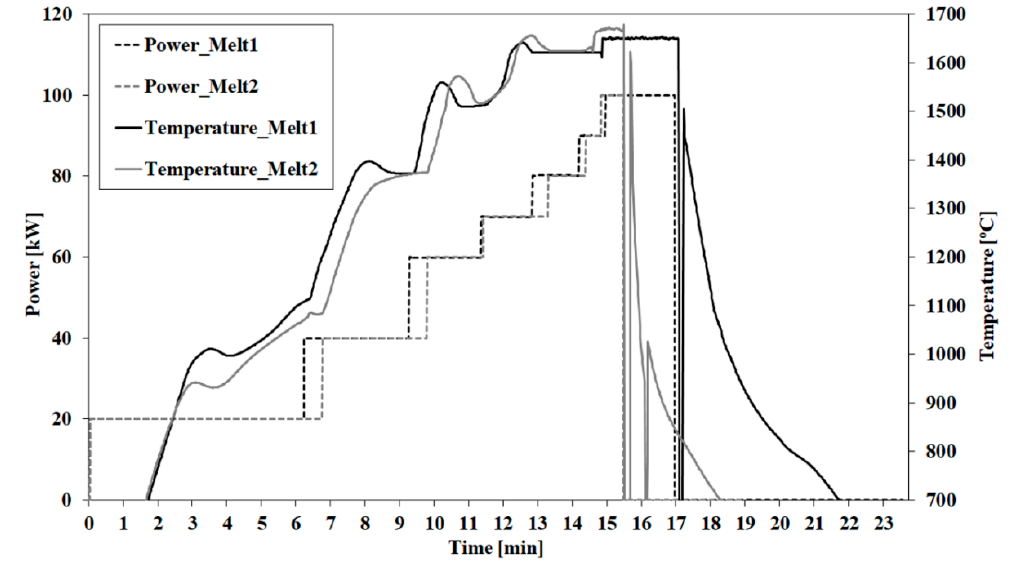
Figure 7. Power profile and charge temperature evolution.